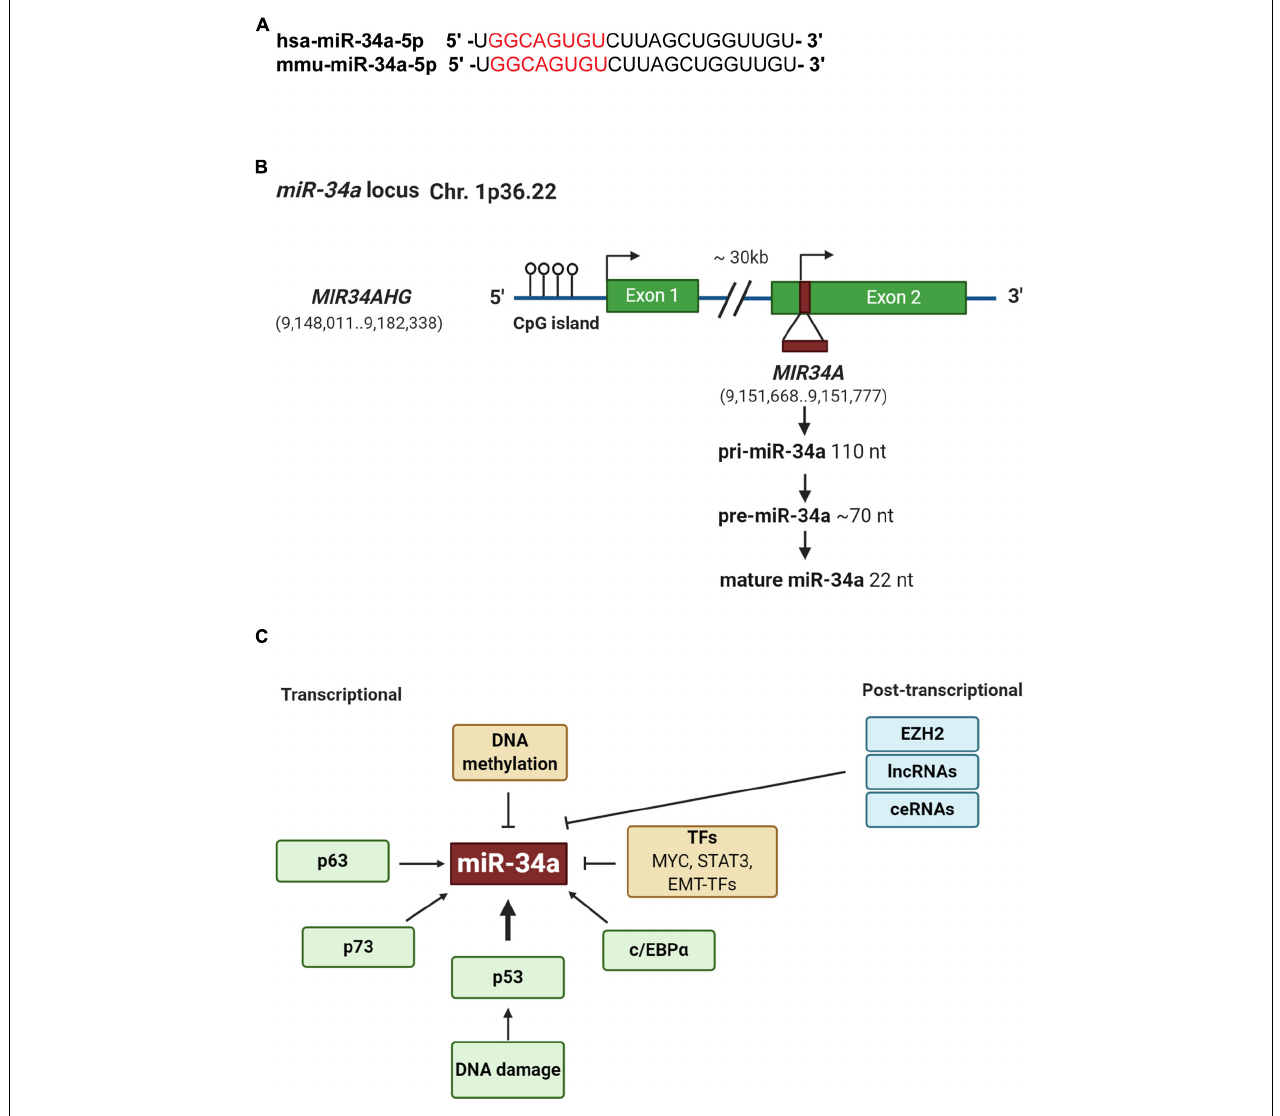
FIGURE 1 | Genomic structure and regulation of miR-34a. (A) Sequence alignment of the mature human and mouse miR-34a. The seed sequences are highlighted in red. (B) Structure of miR-34a genomic loci. Green boxes represent exons. Horizontal arrow marks transcription start site. (C) Regulation of miR-34a. At the transcriptional level, p53, p63, and p73 induces whereas DNA methylation, TME-TFs such as SNAIL and ZEB1, STAT3, and Myc repress miR-34a expression. At the posttranscriptional level, EZH2, lncRNAs, and competing endogenous RNAs (ceRNAs) may negatively regulate miR-34a